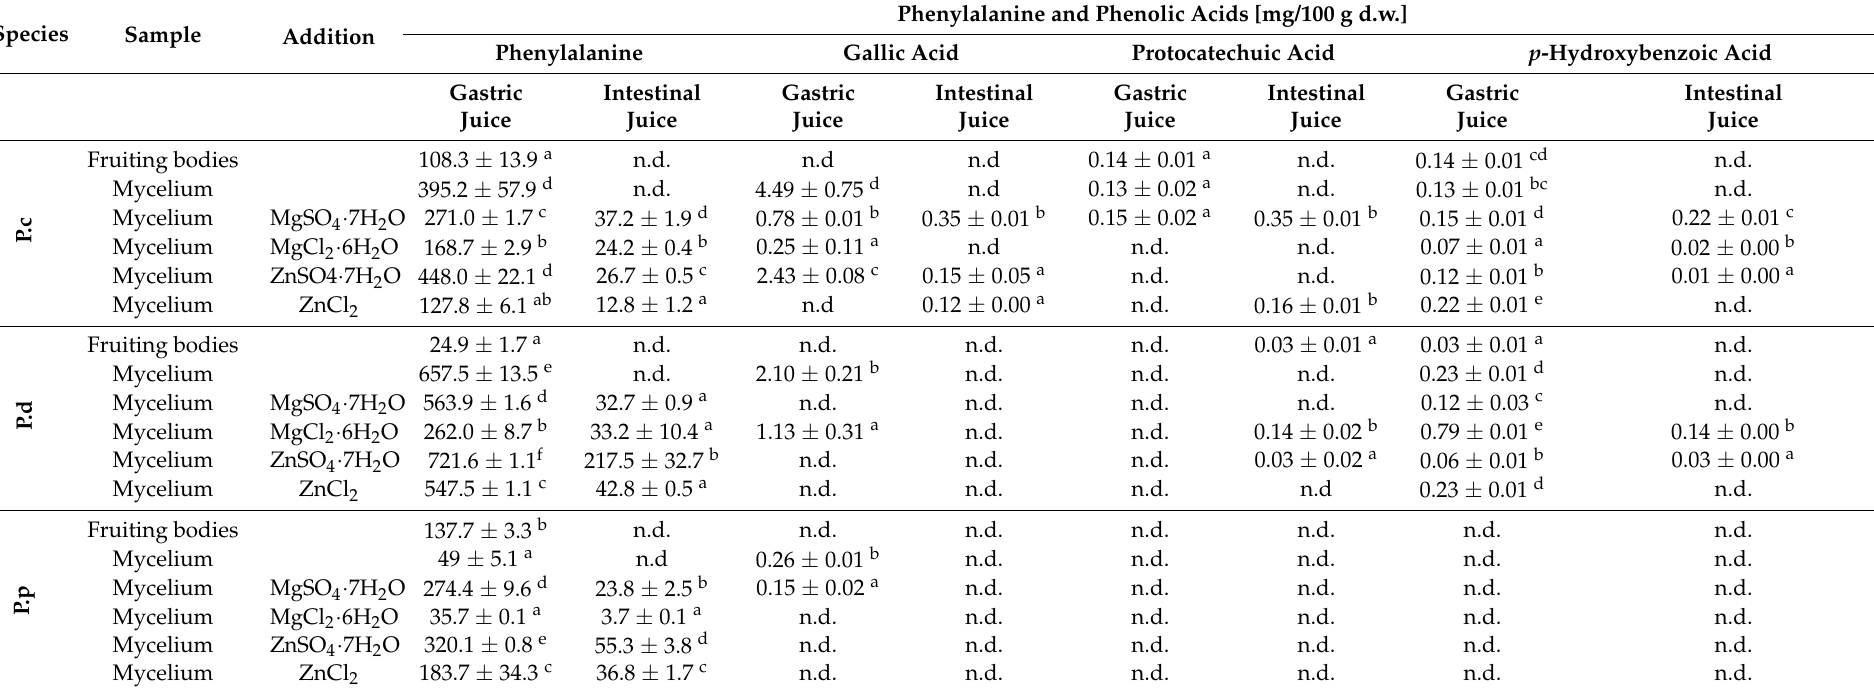
Table 3. Phenolic and indole compounds content extracted into the artificial digestive juices from the biomass obtained from in vitro cultures of P.c — Pleurotus citrinopileatus , P.d —Pleurotus djamor , and P.p —Pleurotus pulmonarius (mg/100